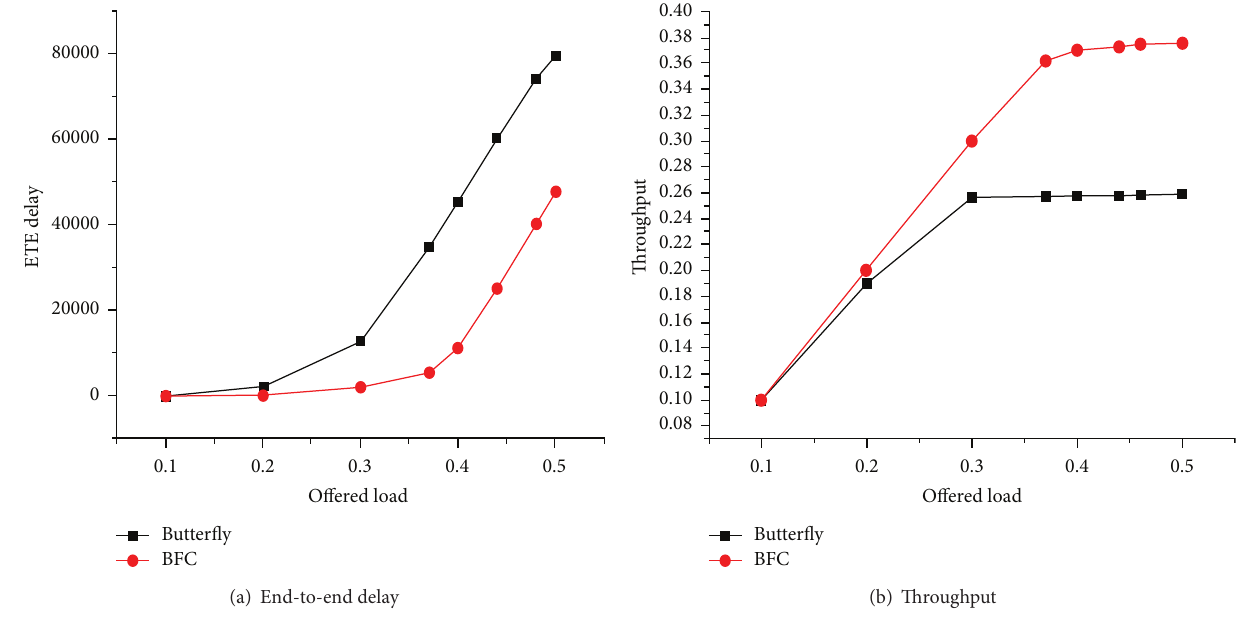
Figure 13: Performance comparison of two uniform traffic